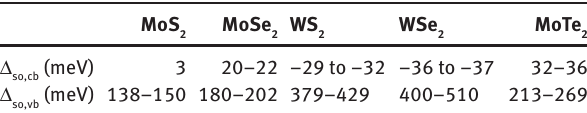
) and valence ( Δ ) bands in so,cb so,vb